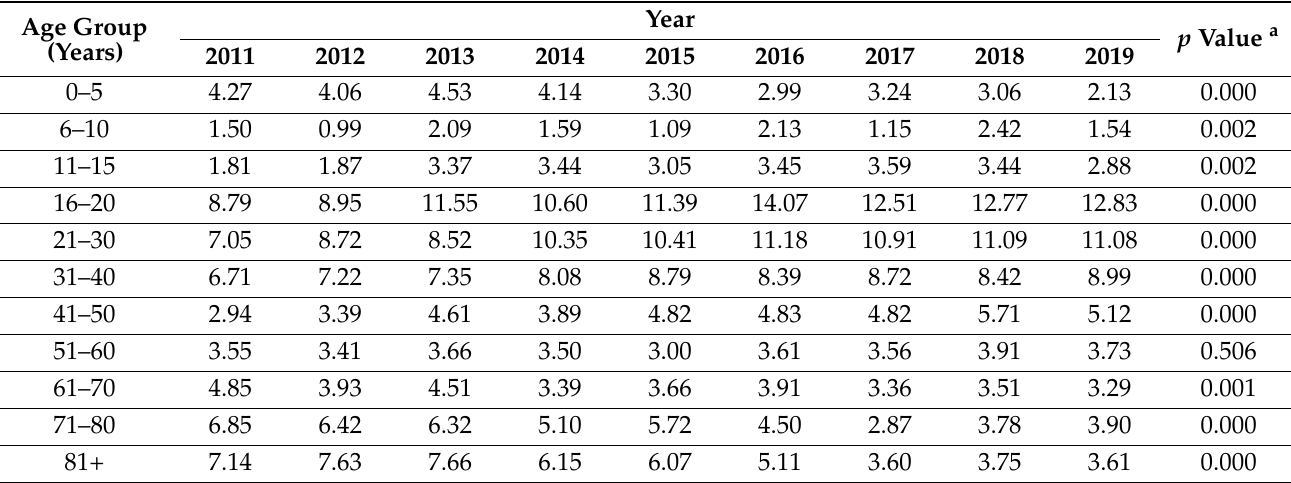
Table 1. Incidence of patients with myocarditis by the number of 100,000 residents in Poland in a given age group in the years 2011–2019.